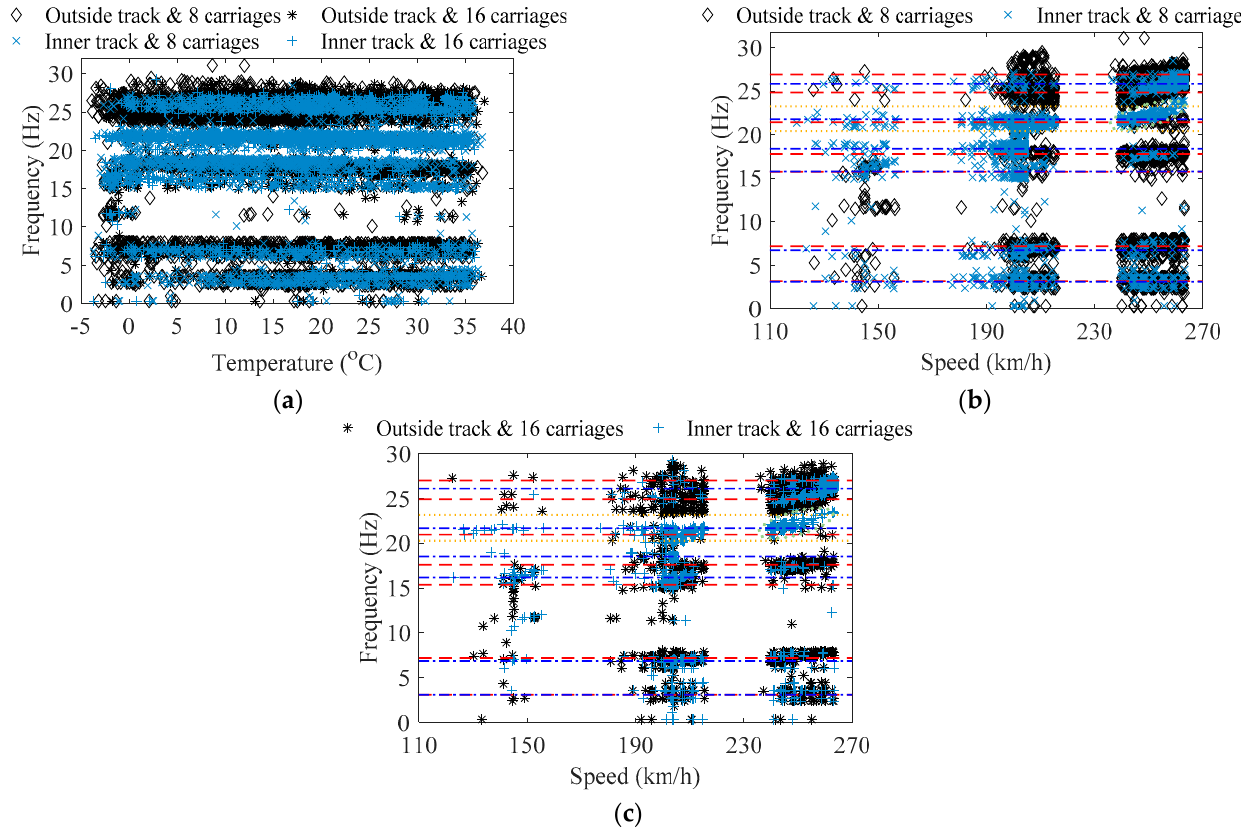
Figure 11. Frequency stability of the train-induced forced vibration: ( a ) influence of temperature; ( b ) influence of train speed in the cases of 8 carriages; ( c ) influence of train speed in the cases of 16 carriages.